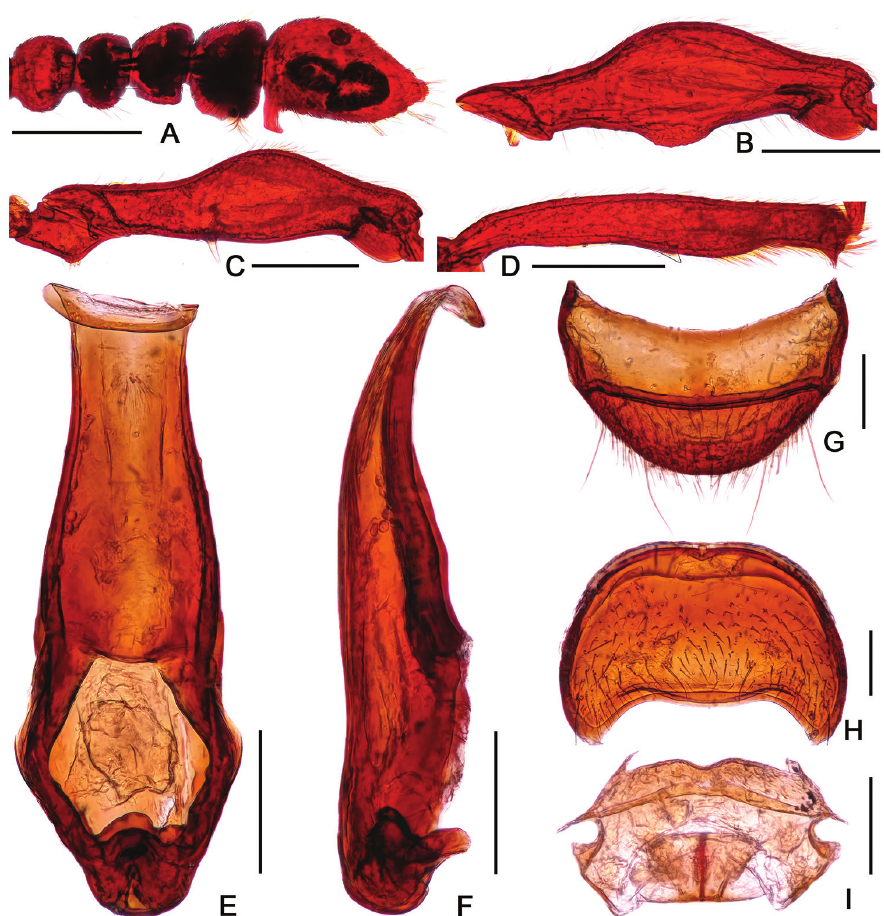
Figure 9. Diagnostic features of Batrisodes xuhaoi ( A–F Male G–I Female). A Antennal club B Profe- mur C Mesotrochanter and mesofemur D Mesotibia E–F Aedeagus, in ventral ( E ), and lateral ( F ) views ( G ) Tergite VIII ( H ) Sternite VIII ( I ) Genital complex. Scale bars: 0.2 mm ( A–D ); 0.1 mm ( E–I